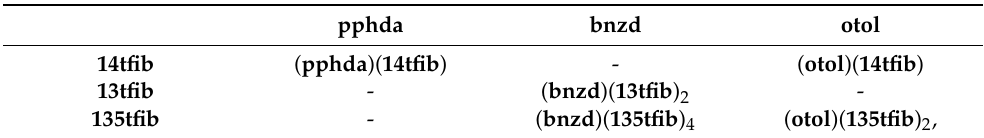
Table 1. An overview of the obtained cocrystals of aromatic diamines and perfluorinated iodoben-